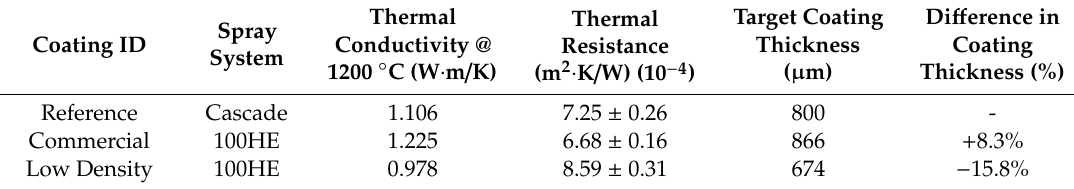
Table 5. Comparison of coating thermal resistance and target coating